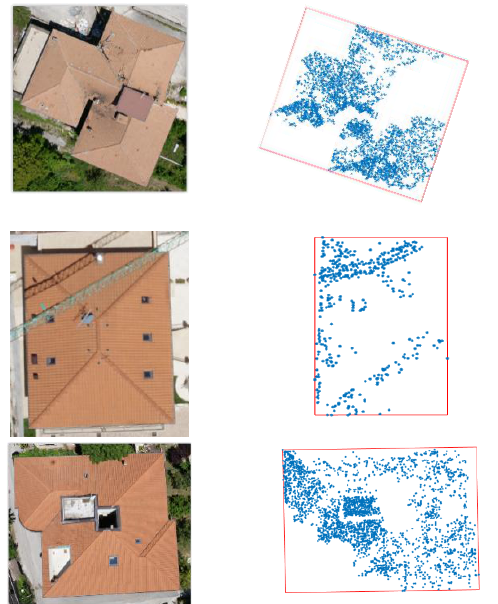
Figure 7 Façade definition. Nadir view of 3 buildings, left and corresponding xy projected sparse points (blue points), and minimum area bounding rectangle (red rectangle), right